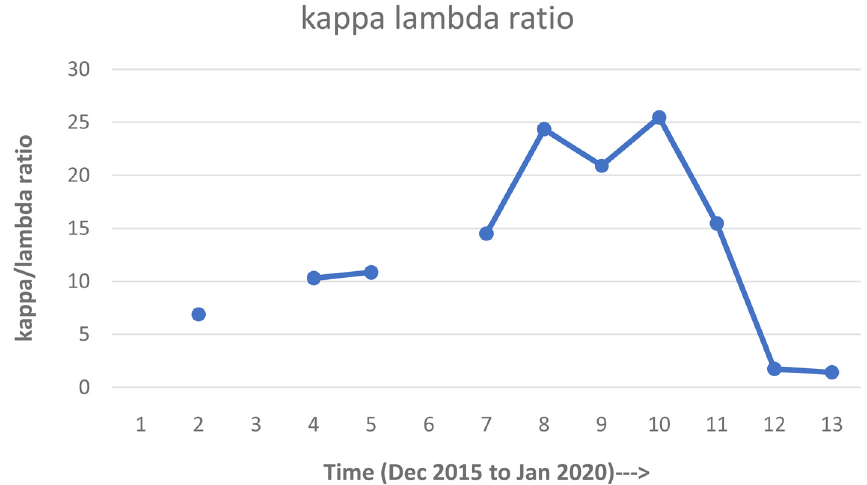
Figure 2. Graphical trend of kappa/lambda ratio.